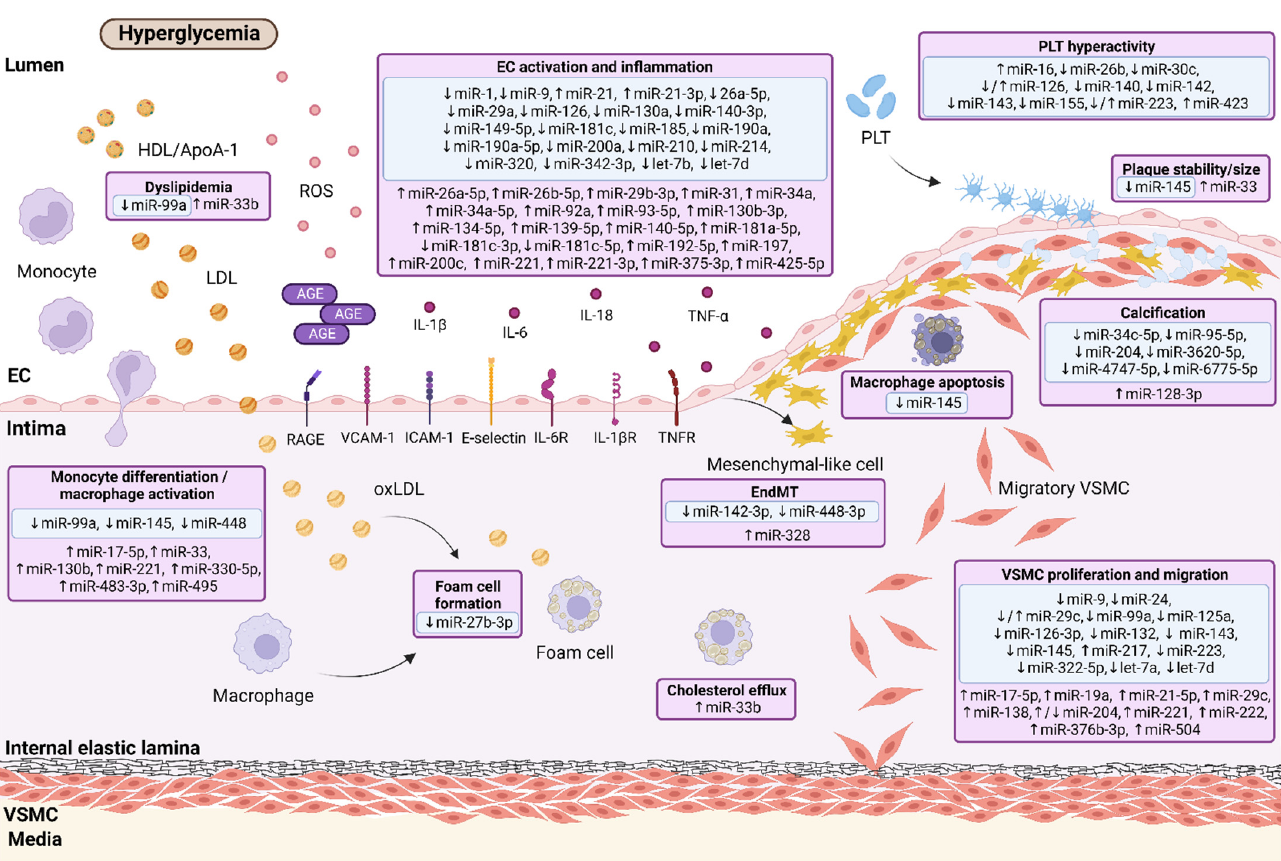
Figure 2. MicroRNAs implicated in T2DM-related atherosclerosis. Positive/atheroprotective (in green frame) and negative/atherogenic (in violet frame) effects of miRNAs on every step of the ath- erosclerotic process under diabetic conditions are shown. Chronic hyperglycemia induces inflam- mation, and oxidative stress leading to the cascade of processes, including EC activation, migration of monocytes into the intima and their maturation into macrophages, foam cell formation by oxLDL uptake, PLT hyperactivity, VSMC proliferation and migration into the intima. Single miRNAs are also found to be engaged in EndMT, calcification, and regulation of plaque size/stability.